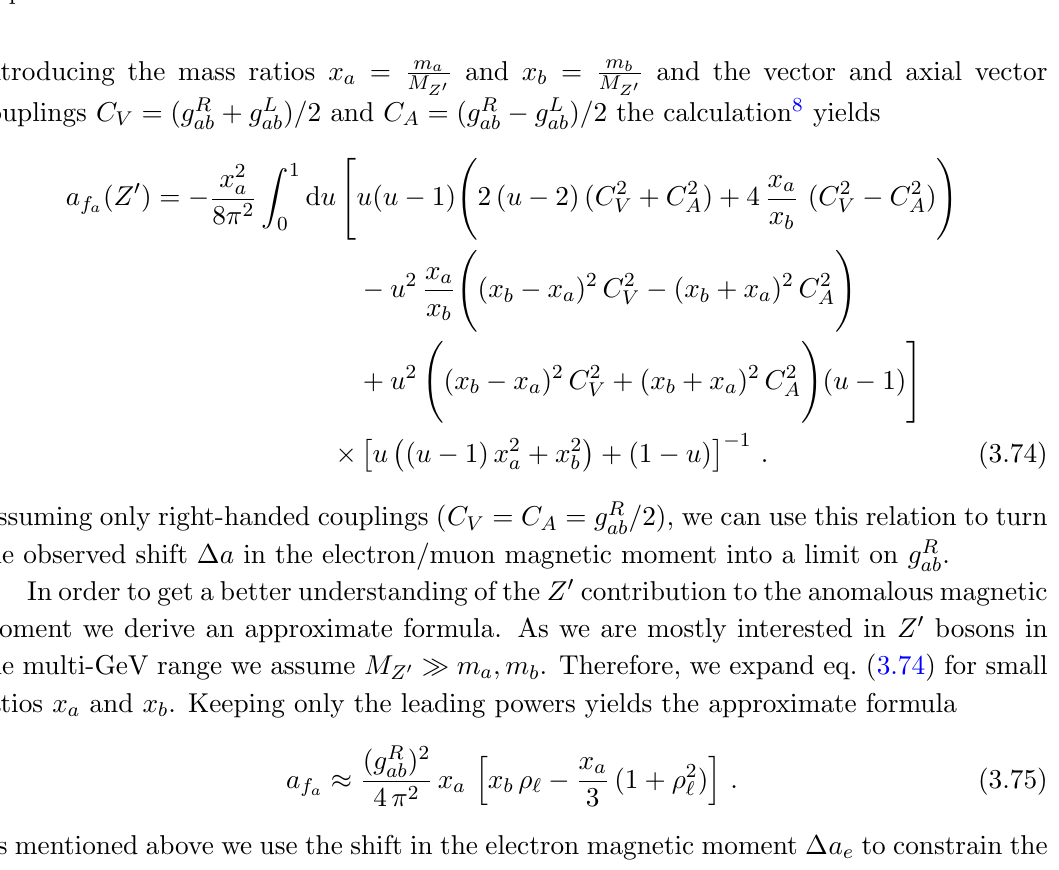
Figure 17 . Anomalous magnetic moment of fermion f a due to Z 0 exchange and f b running in the